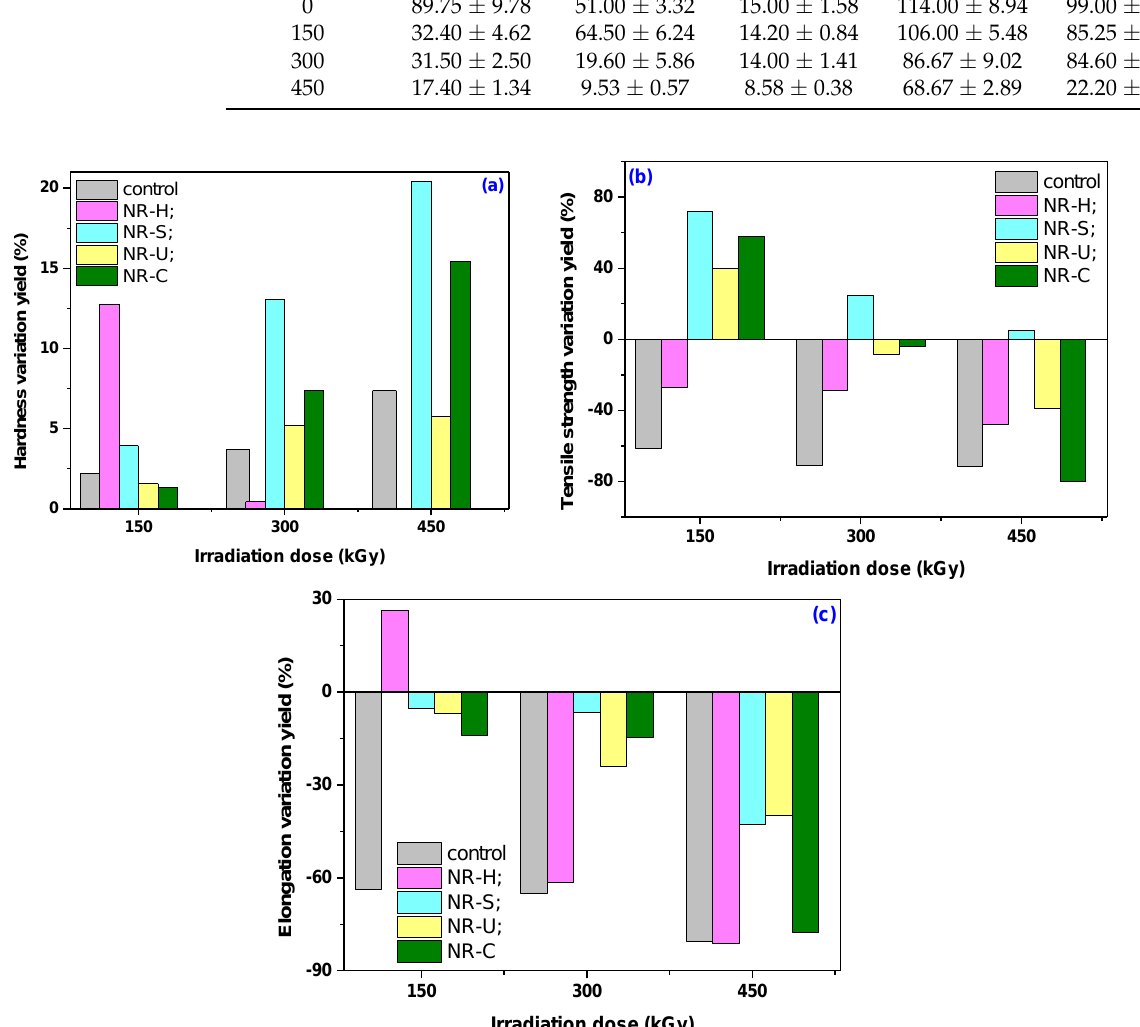
Figure 1. The mechanical properties modification yield of the irradiated versus non-irradiated samples: ( a ) hardness, ( b ) tensile strength, ( c ) elongation at break. Table 3. The mechanical properties variation as a function of irradiation dose and filler type. Irradiation